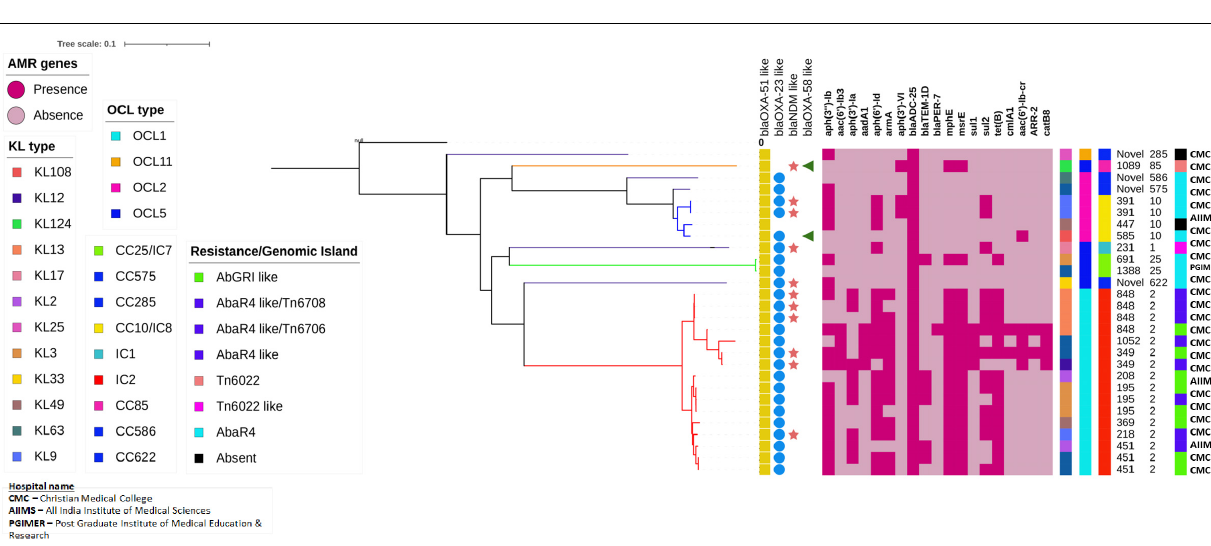
FIGURE 9 | Single nucleotide polymorphism (SNP)-based phylogenetic tree of carbapenem-resistant Acinetobacter baumannii sequenced in this study. The color-filled shape denoted presence, while the empty shape denoted the absence of the respective traits. The heat map represents the presence or absence of AMR genes; Dark red indicates the presence of the respective gene, while light red indicates the lack of the respective gene. The capsular types (KL), outer core lipopolysaccharide types (OCL), International clones/clonal complexes, and resistance/genomic islands of the CRAb isolates were represented by color-coded boxes as given in the legend. The Oxford and Pasteur scheme sequence types (STs) were given as text